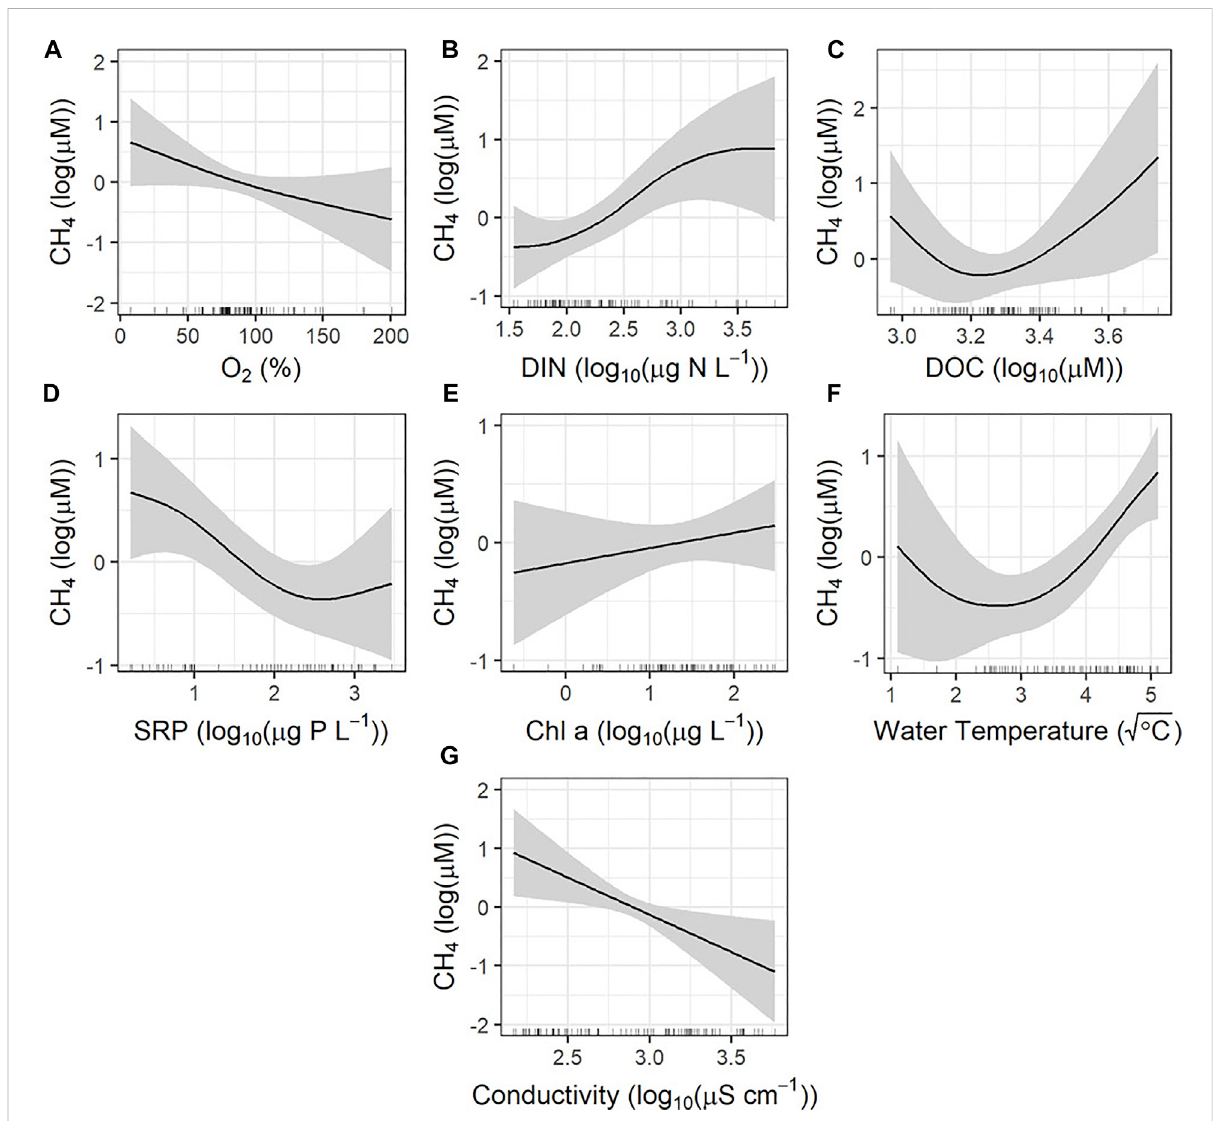
FIGURE 5 Partial effects plots from generalized additive models assessing the seasonal controls of methane (CH 4 ). Model deviance explained was 74.5%. Shaded region represents the 95% con fi dence interval. The rug along the x -axis indicates the distribution of observations. (A) Dissolved oxygen saturations; signi fi cant. (B) Dissolved inorganic nitrogen concentration; signi fi cant. (C) Dissolved organic carbon concentration; signi fi cant. (D) Soluble reactive phosphorus concentration; signi fi cant. (E) Chl- a concentration; not signi fi cant. (F) Water temperature; signi fi cant. (G) Conductivity; signi fi